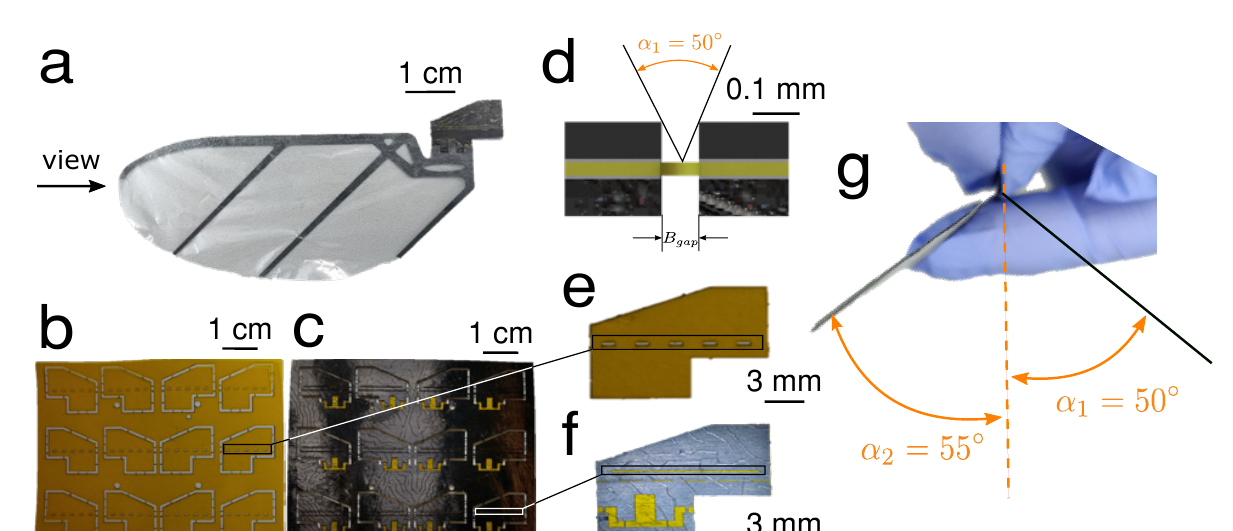
Figure 7. Robot wing and hinge design. ( a ) Side view of wing structure with wing frame and passive hinge. The hinge is constructed as a laminate with flexure ( b ) and CF layers ( c ) laminated with adhesive layers (Pyralux 1500). ( d ) Cross-sectional view of wing hinge, indicating mechanical stop angle. ( e ) New Kapton membrane was cut off a raster-like space to decrease the stiffness of the hinge structure to increase the acceleration of the angle-of-attack when flapping. ( f ) We added a groove to the wing to wick any glue spillage to protect the wing hinge gap from interference from the glue. ( g ) The mechanical stop ensures that the angle-of-attack at two mid-strokes is near 50 ◦ in both